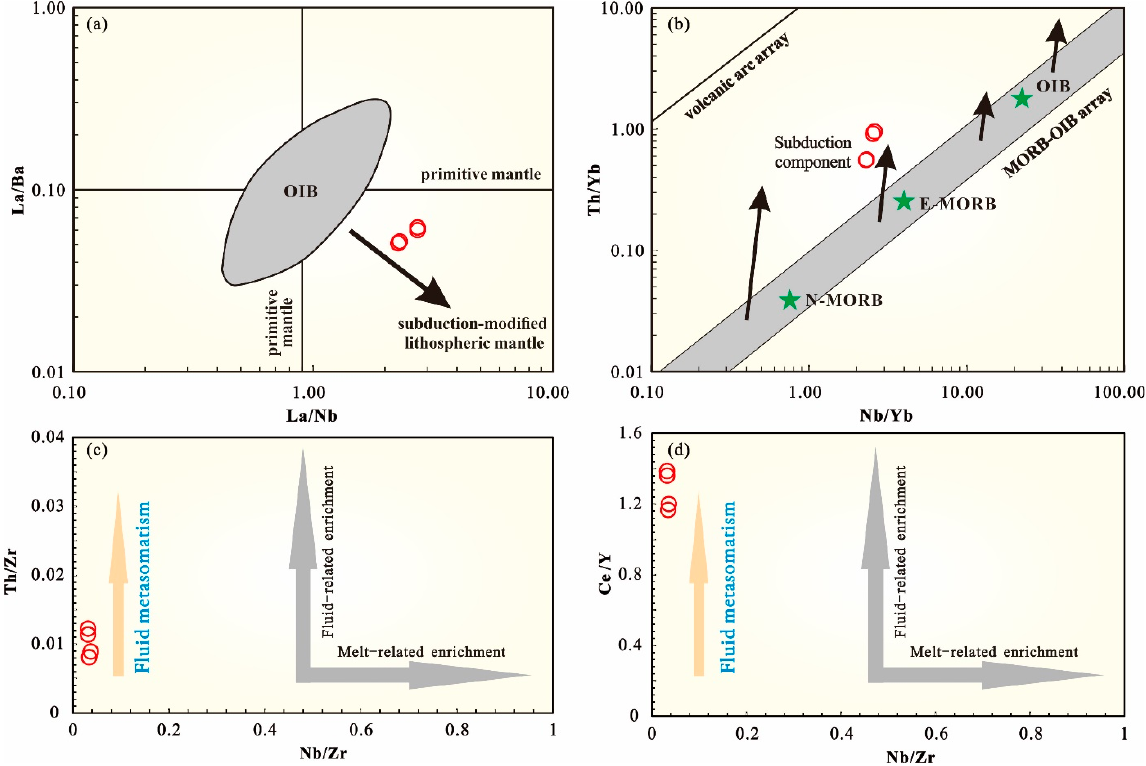
Figure 8. Binary plots of the hornblende gabbro samples from the Baogeqi gabbro pluton: ( a ) La/Ba vs. La/Nb [58]; ( b ) Th/Yb vs. Nb/Yb [59]; ( c ) Nb/Zr vs. Th/Zr [60]; ( d ) Nb/Zr vs. Ce/Y [56].